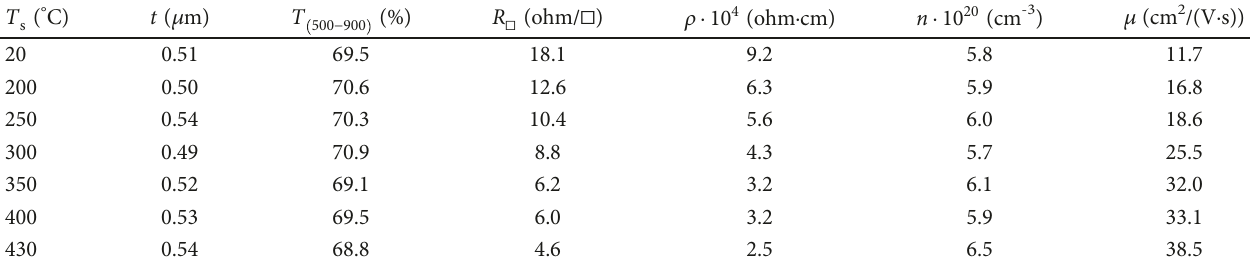
Figure 1: The crystal structure of ITO fi lms on the polyimide fi lm ( P after annealing. Table 1: The e ff ect of deposition temperature on the optical and electrical properties of ITO layers formed on fl exible substrates. ° C) Т s (